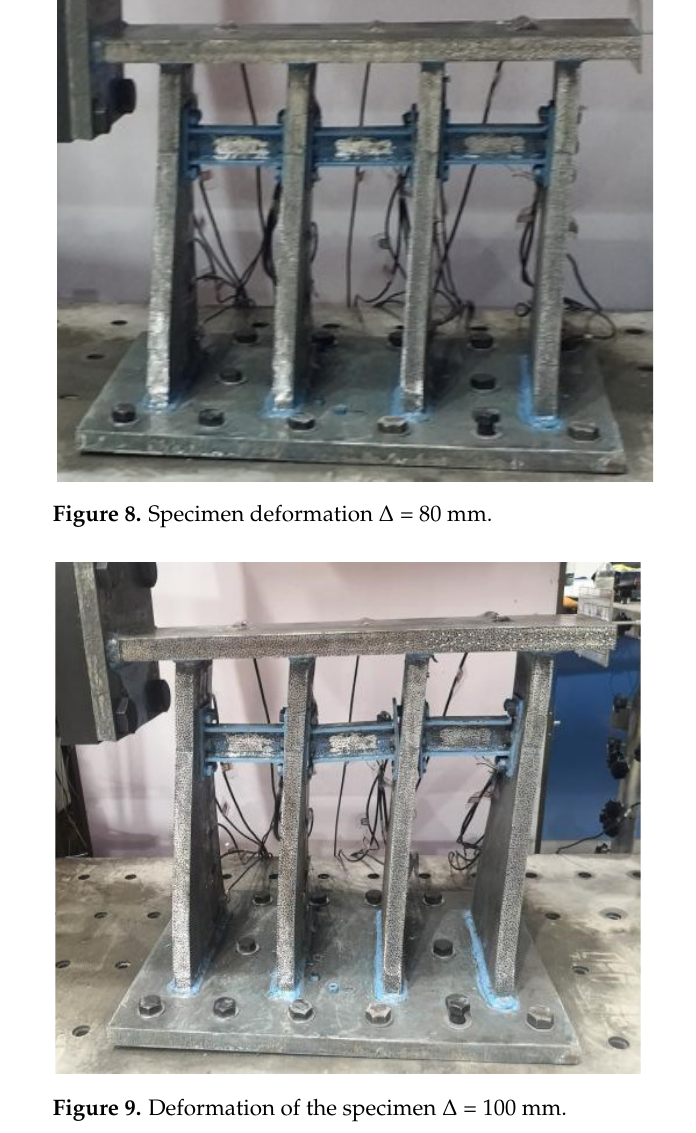
Figure 9. Deformation of the specimen Δ = 100 mm.